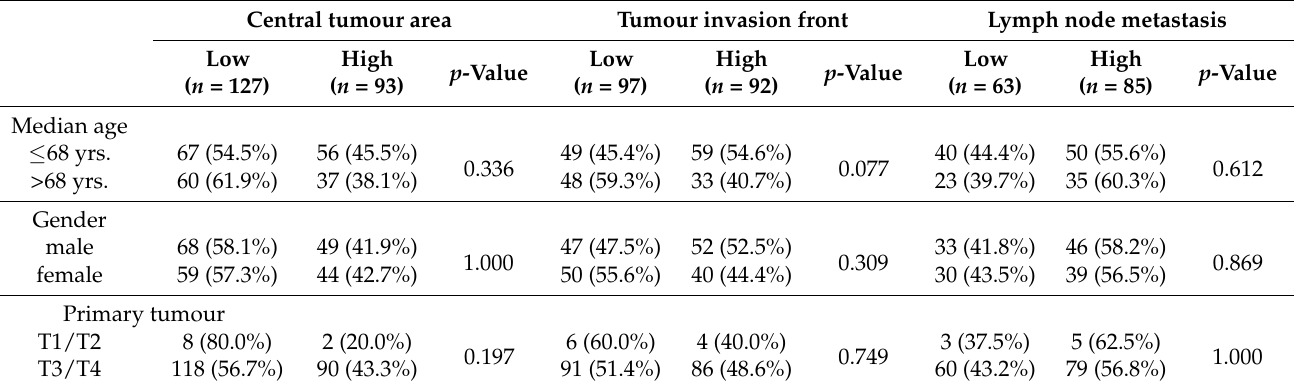
Table 3. Cytoplasmic survivin expression 1